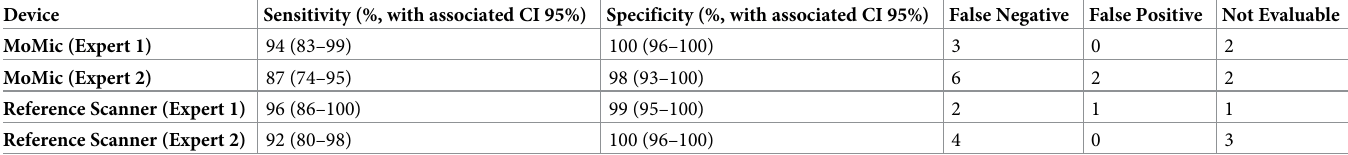
Table showing overall sensitivity, specificity, total number of FN and FP, and slides classified as not evaluable. Results calculated on a slide level, compared to ground